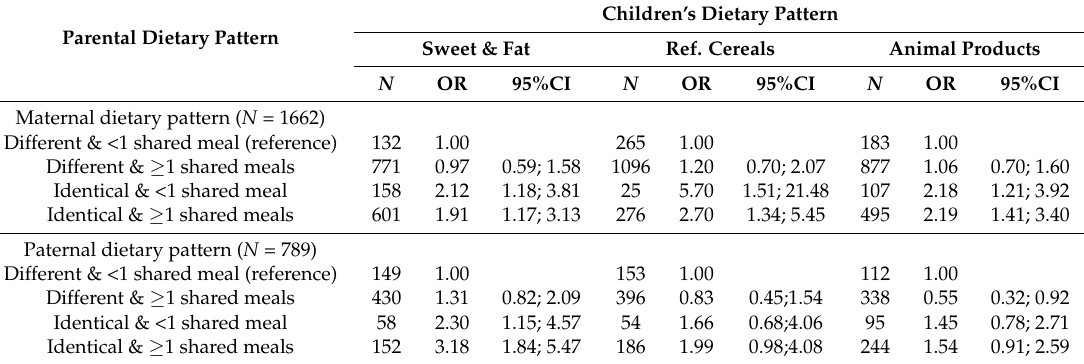
Table 4. Odds Ratios (OR) and confidence intervals (CI) for a child being allocated to a dietary pattern depending on parental dietary pattern and number of shared daily meals, given by sex of parents; all models were adjusted for age and BMI z -score of child, parental BMI, highest ISCED of family, and country of